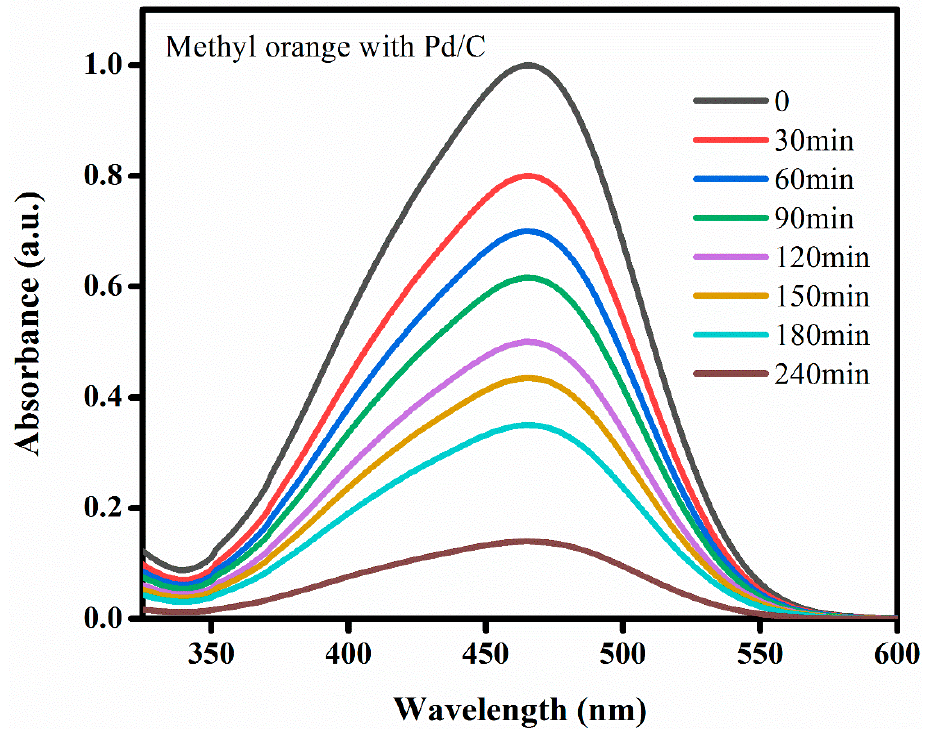
Figure 7. UV–Vis spectra of MO degradation with the Pd/C as catalyst. Table 3. Literature review on the degradation of dyes using Pd NPs as catalysts.